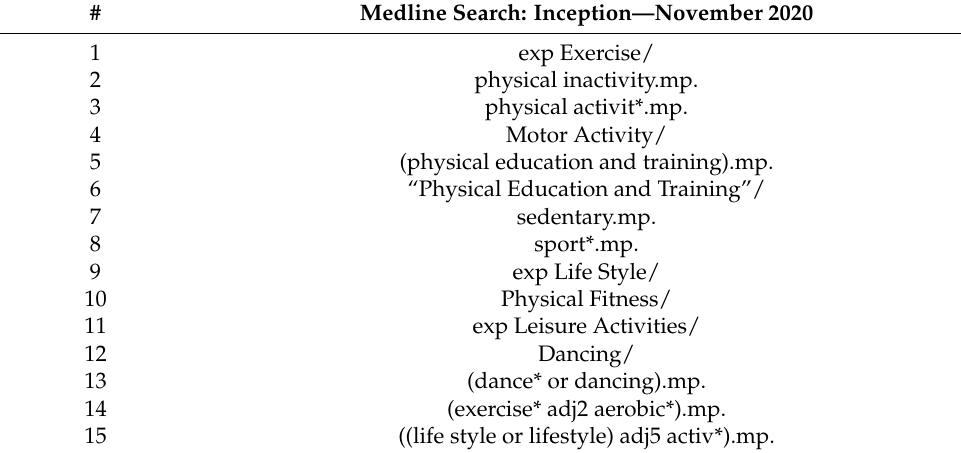
Table A1. Online database search